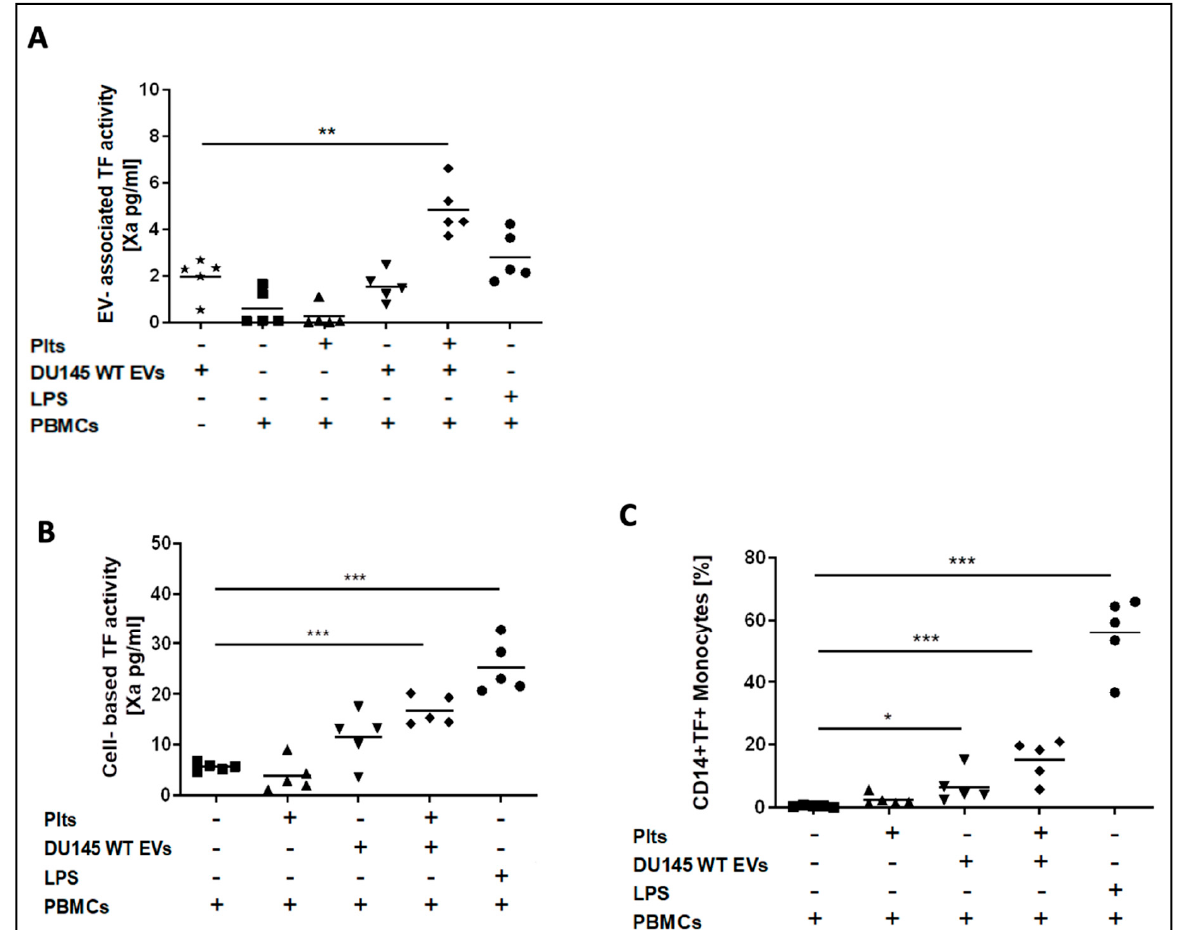
Figure 4. Co-incubation of conditioned media from TF-exposing DU145 prostate cancer cells with peripheral blood mononuclear cells (PBMCs) and platelets. EV-TF activity was detectable in conditioned media from the DU145 cell line. Low EV-TF activity was found in conditioned media from PBMCs alone and PBMCs that were co-incubated with platelets. Co-incubation of PBMCs with DU145 EVs did not significantly increase EV-TF activity. EV-TF activity significantly increased when DU145 EVs, PBMCs, and platelets were co-incubated ( A ). Cell-based TF activity was detectable but low on unstimulated PBMCs and PBMCs that were co-incubated with platelets. Cell-based TF activity significantly increased by co-incubation of PBMCs with EVs from DU145 cells and further increased when platelets were added ( B ). By applying flow cytometry, we found that only monocytes (CD 14+) expose TF but not lymphocytes (CD14 − ) after co-incubation with DU145-derived EVs and platelets ( C ). Cell-based TF activity (pg/mL) was determined in triplicate. Each dot represents a single measurement and the line represents the mean. (* p ≤ 0.05, ** p ≤ 0.01, *** p ≤ 0.001, paired comparison for repeated measurements). Abbreviations: LPS — lipopolysaccharide.